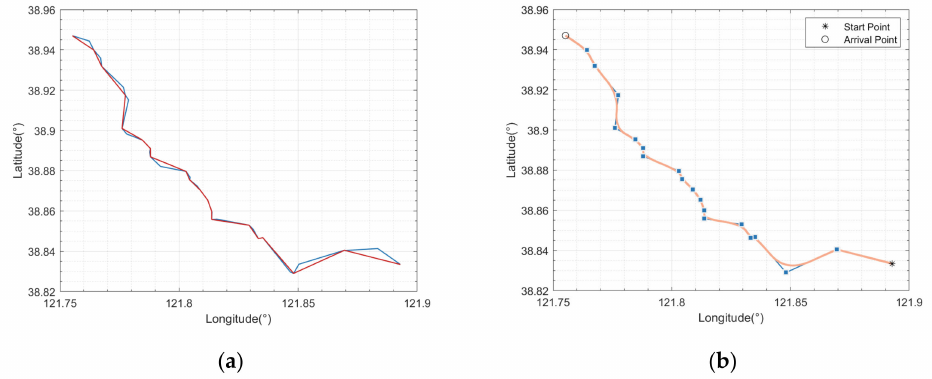
Figure 12. Path smoothing effect. ( a ) Comparison between waypoint and before optimization. The blue line represents the path before optimization, and the red line represents the optimized path. ( b ) The action of the B-spline curve. The blue dots represent the waypoints and the orange line represents the final path after optimization.